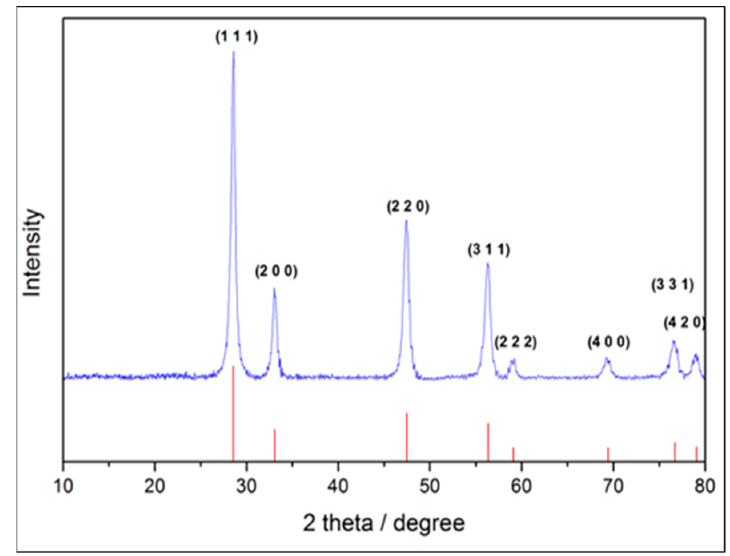
Figure 2. The XRD pattern of CeO 2 nanoparticles. The characteristic diffraction peaks on 2 theta of (111), (200), (220), (311), (222), (400), (331), and (420), respectively, were fully matched to standard cerium oxide pattern of JCPDS No. 340394.